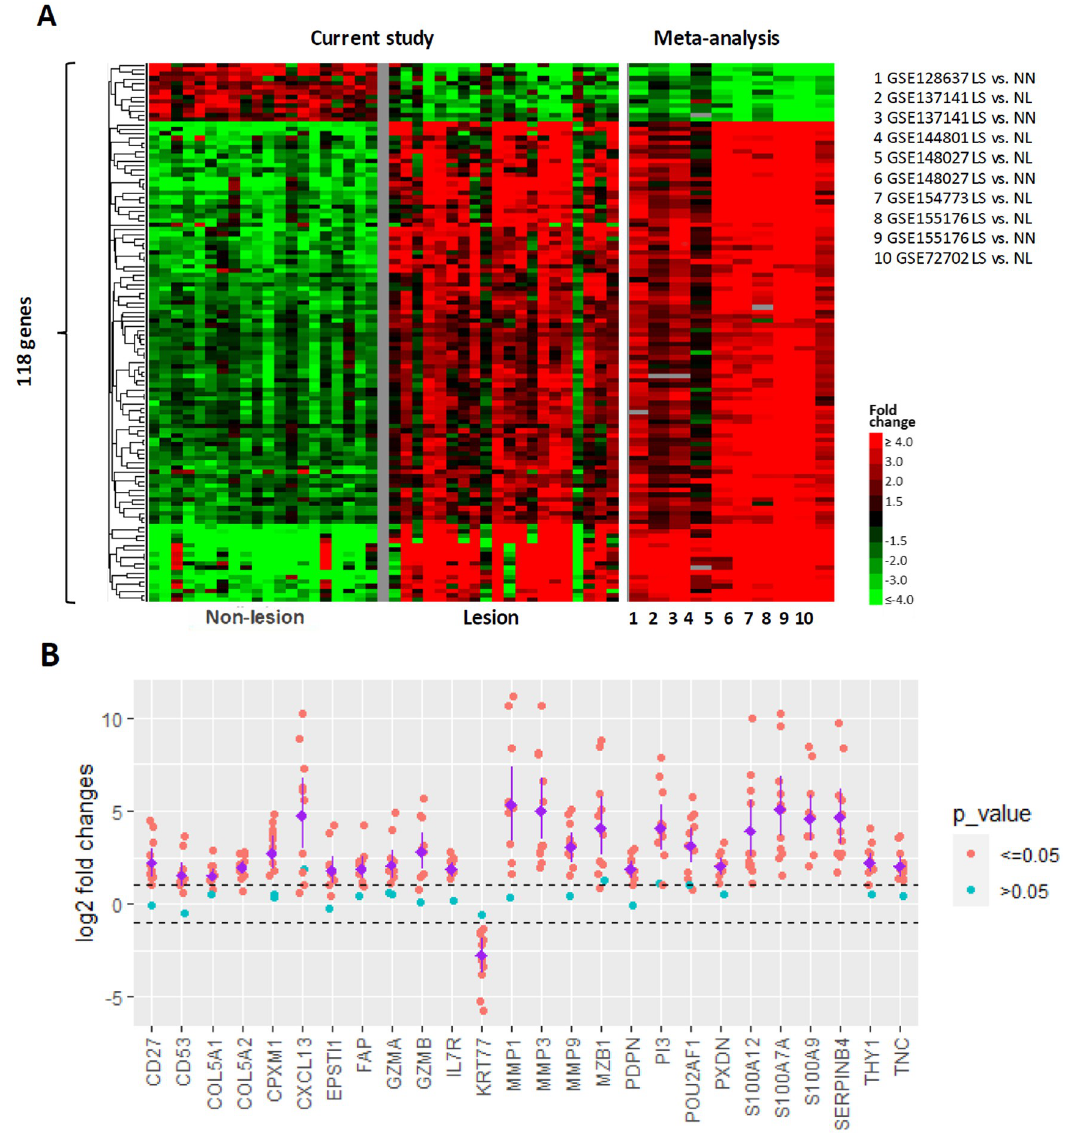
Fig 3. Joint re-analysis of HS skin bulk RNA transcriptomics datasets and comparison to the current study. 118 protein coding genes were identified as being consistently differentially expressed when comparing lesion and non-lesion samples across HS cohorts and platforms (A). The heatmap shows the gene expression patterns (rows) for each individual patient sample in the current study and average fold changes for the previously published datasets (columns). The consistent patterns across studies suggests overall relatively high concordance between cohorts. Log2 fold change estimates in the current and previously published studies for select genes in the HS disease signature are shown for individual cohorts (B). The dashed lines represent two fold differences in either direction, blue and red dots represent significance levels, and purple dots and lines represent range and average fold changes. Even though fold changes and p-values vary considerably, it is clear that this panel is consistently dysregulated in HS.